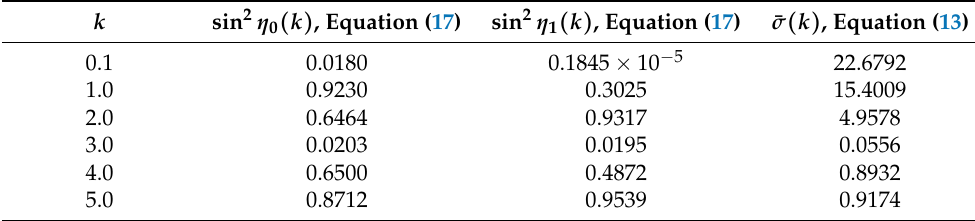
Table 1. Evaluations of the molecular phases and related quantities. All parameters are given in atomic units.